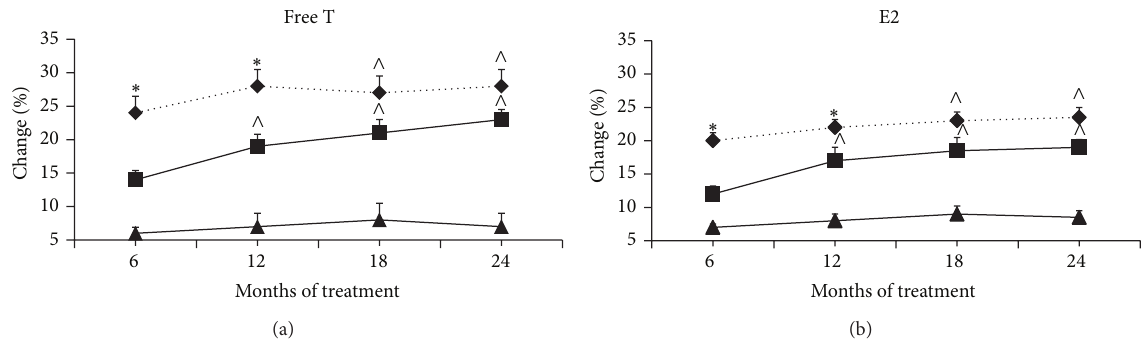
Figure 3: Changes in serum levels of free T and E2 throughout 24 months of treatment. Note: data are means ± SD. T: testosterone; E2: estradiol; ∗ : 𝑃 < 0.05 versus baseline, groups B and C; ∧ : 𝑃 < 0.05 versus baseline and group C. ⧫ : group A, the standard-dose TU group; ◼ : group B, the low-dose TU group; 󳵳 : group C, placebo